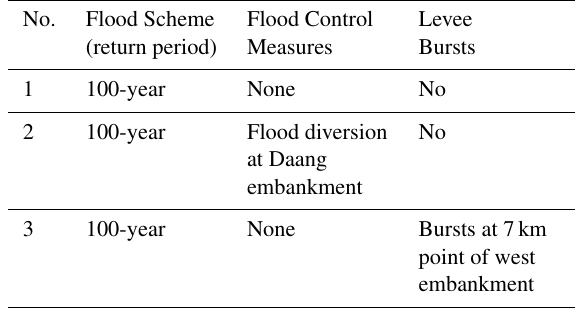
Figure 10. Discharge at Qiqihar hydrologic station ( P = 1%).